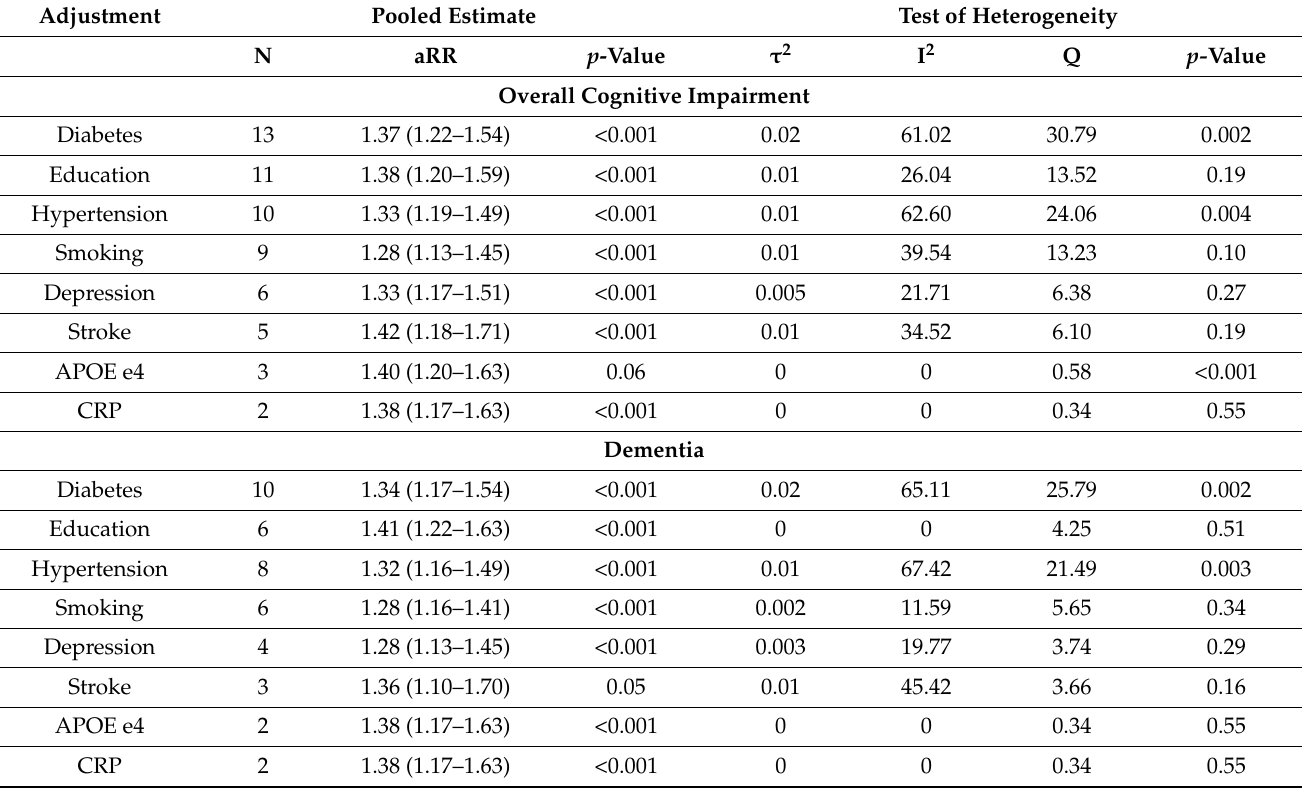
Table 3. Sensitivity